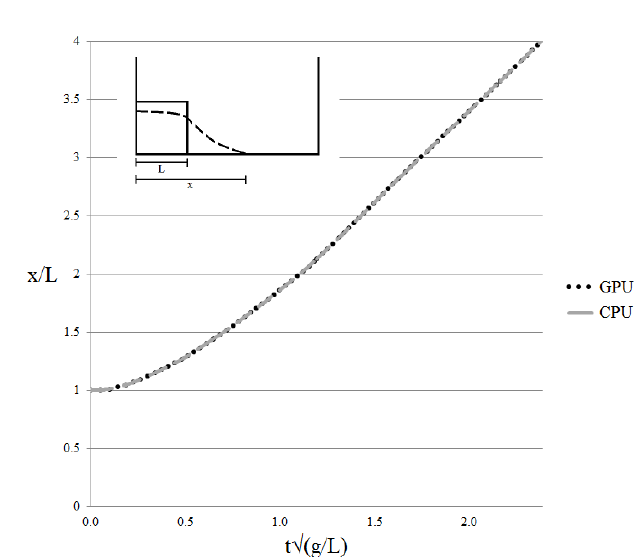
Fig. 9: Evolution of the water wave front through dimension- less time